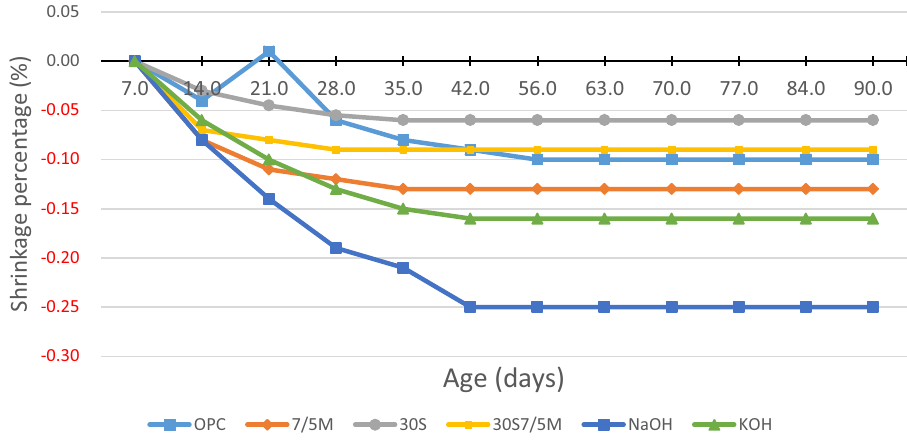
Fig. 12 Drying shrinkage of